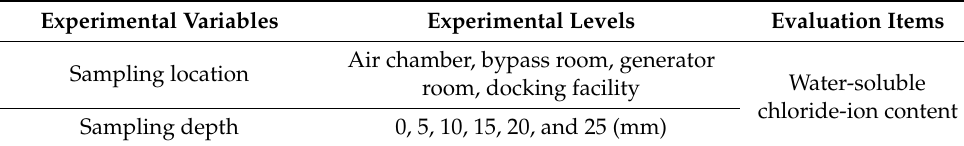
Figure 4. Sampling locations and images of OWC: ( a ) air chamber; ( b ) bypass room, docking facility. Table 2. Design of experiments